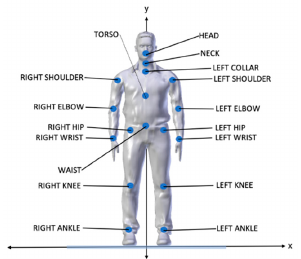
Figure 5. The 17 recognizable joints of the Astra S.